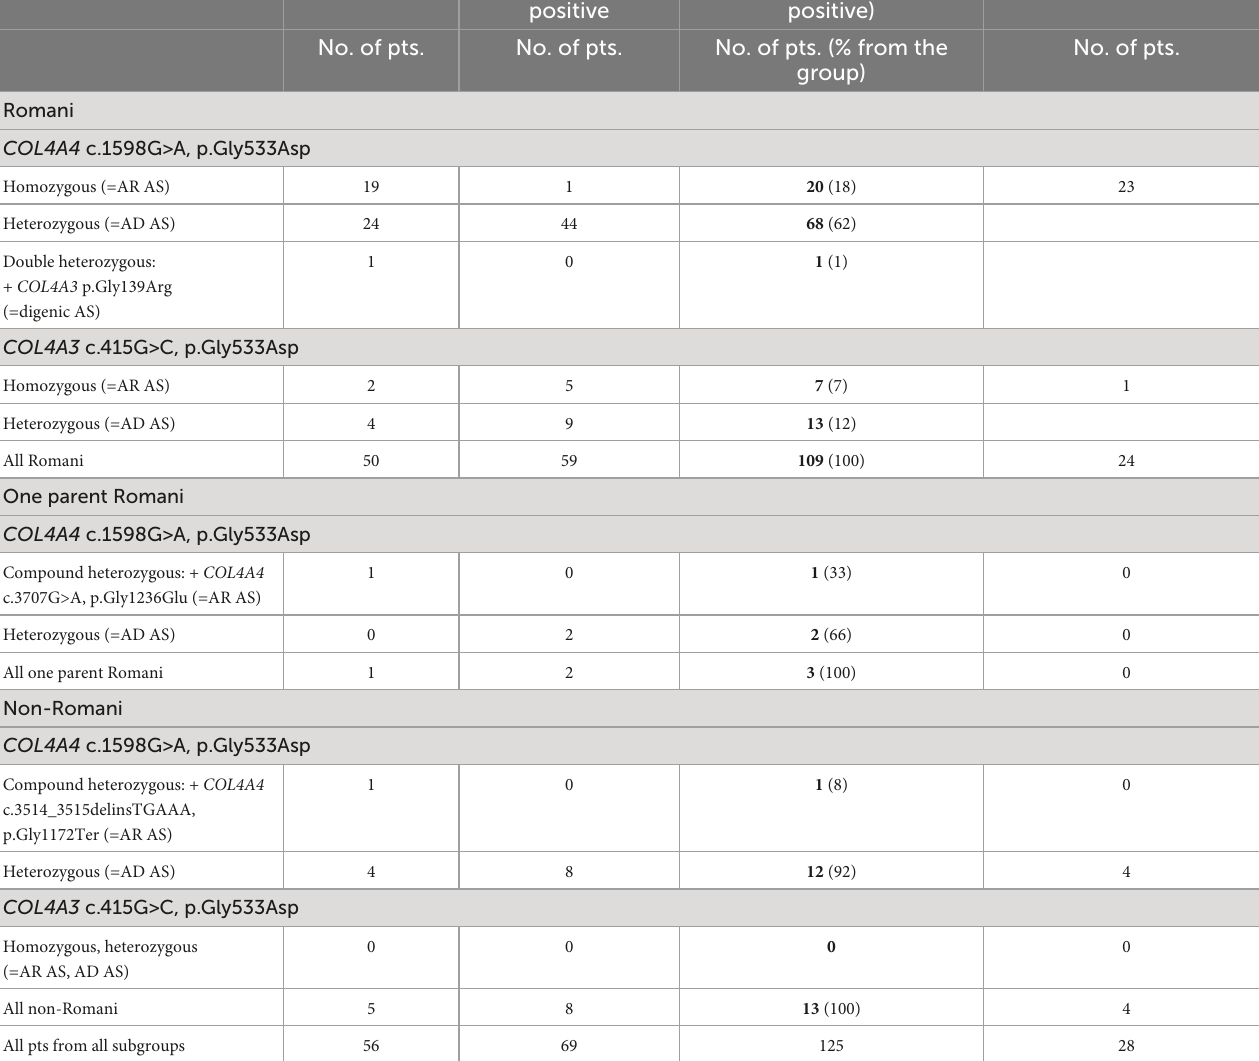
TABLE 1 Summary of pathogenic sequence variants detected in Romani, one parent Romani, and non-Romani patients. Genotype Probands Family genetic